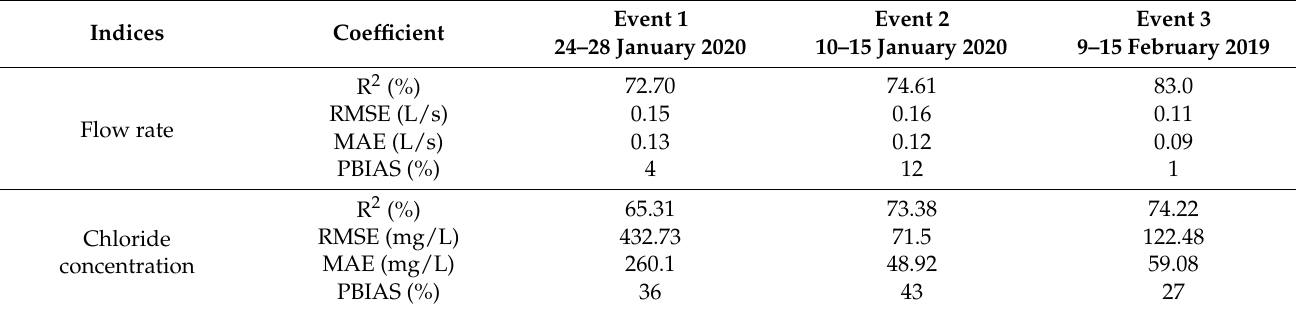
Table 1. Statistical parameters used to evaluate the performance of PCSWMM